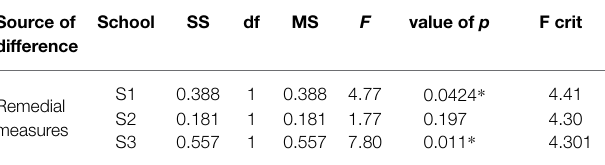
TABLE 7 | ANOVA results of S1, S2, and